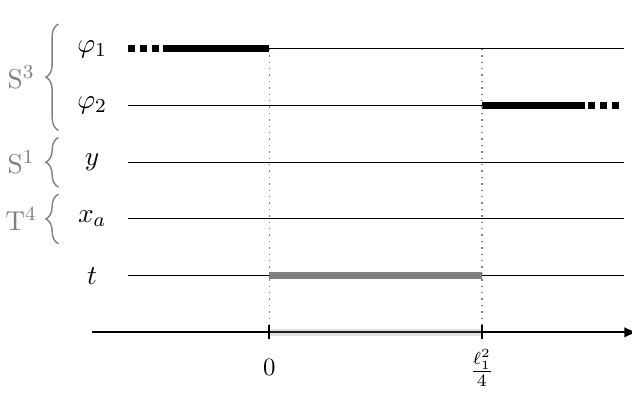
Figure 14 . Rod diagram of the shrinking directions on the z -axis after sourcing the solutions with a rod that forces the degeneracy of the timelike